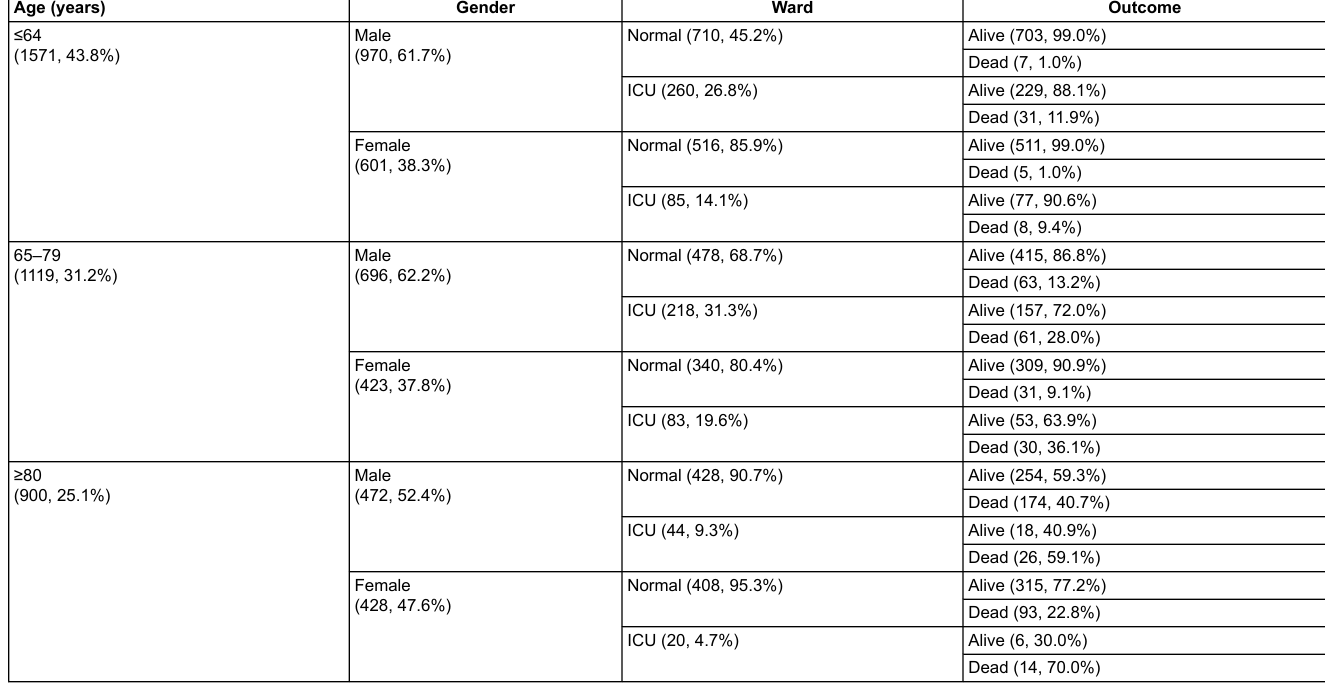
Table S1: Characteristics of all patients, ICU admission and outcome, by age class and gender.